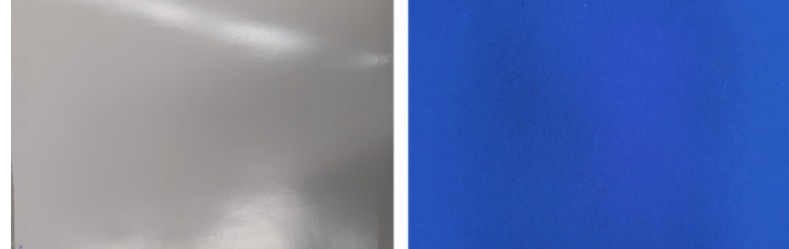
Figure 12. Spray cast membranes of PS 83 - b -P4VP 1788k with 2-fluid/inner mix nozzle, normal image ( left ) and image under UV-light ( right ) after casting and drying.